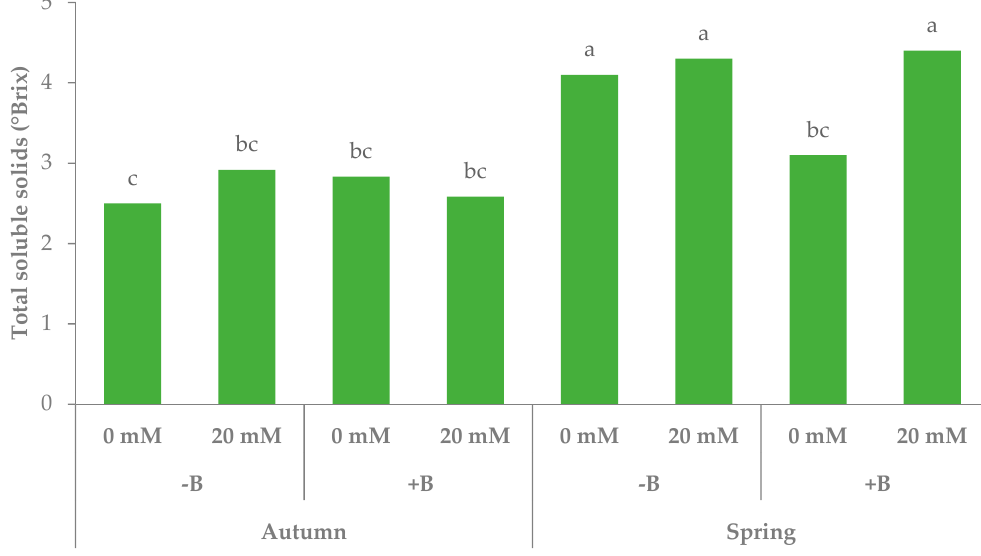
Figure 8. Total soluble solids of the leaf of lettuce plants grown during autumn and spring in nutrient solutions containing different levels of NaCl and with (+B) or without (-B) bacterial biostimulant (bars with different letters are significantly different at p < 0.05, according to the LSD test).